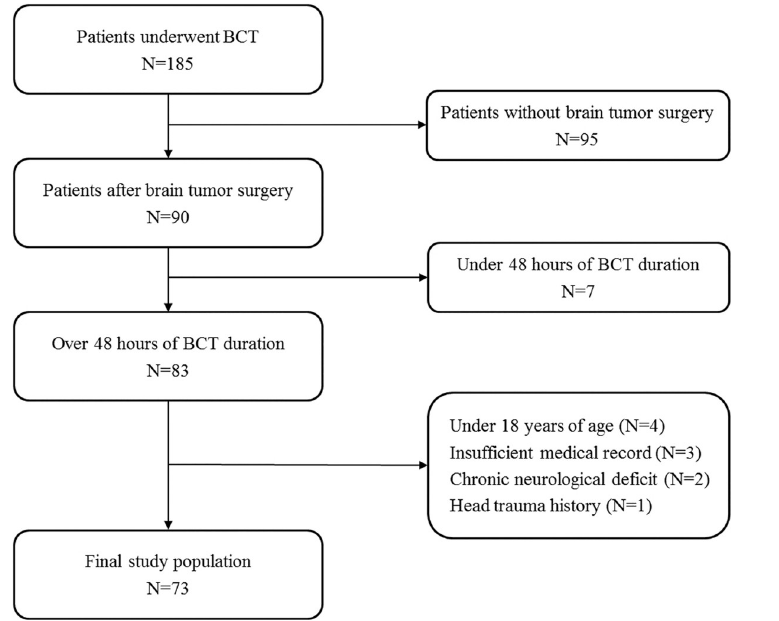
Fig 1. Study flow chart. BCT, barbiturate coma